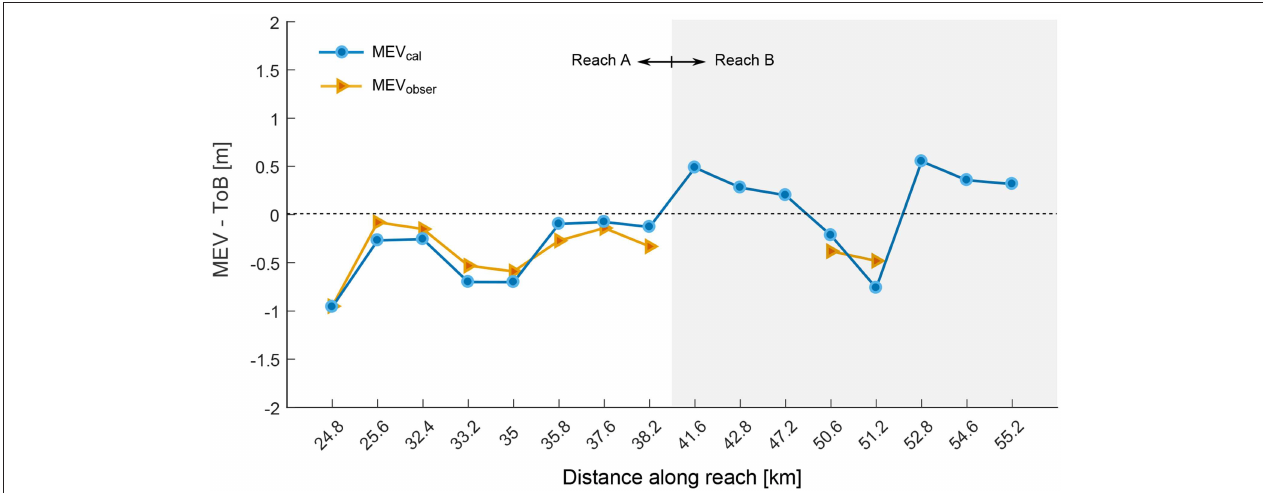
FIGURE 11 | Results of the model validation. The minimum elevation at which the calibrated model predicts vegetation establishment (MEV cal ) is compared with the MEV obser for a series of cross sections along the reach. Bars in the reach A were used for calibrating the